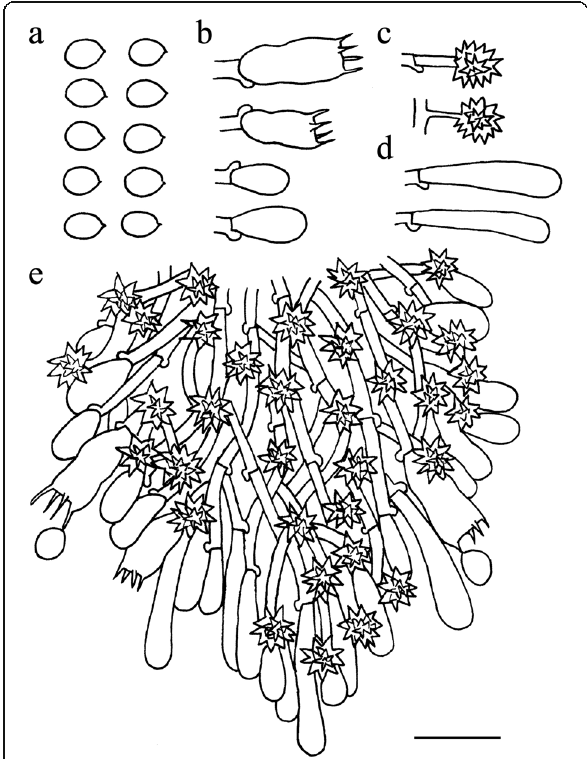
Fig. 5 Microscopic structures of Resinicium austroasianum (drawn from holotype). a basidiospores. b basidia and basidioles. c astrocystidia. d leptocystidia. e apical part of a tooth. Scale bar =10 μ m